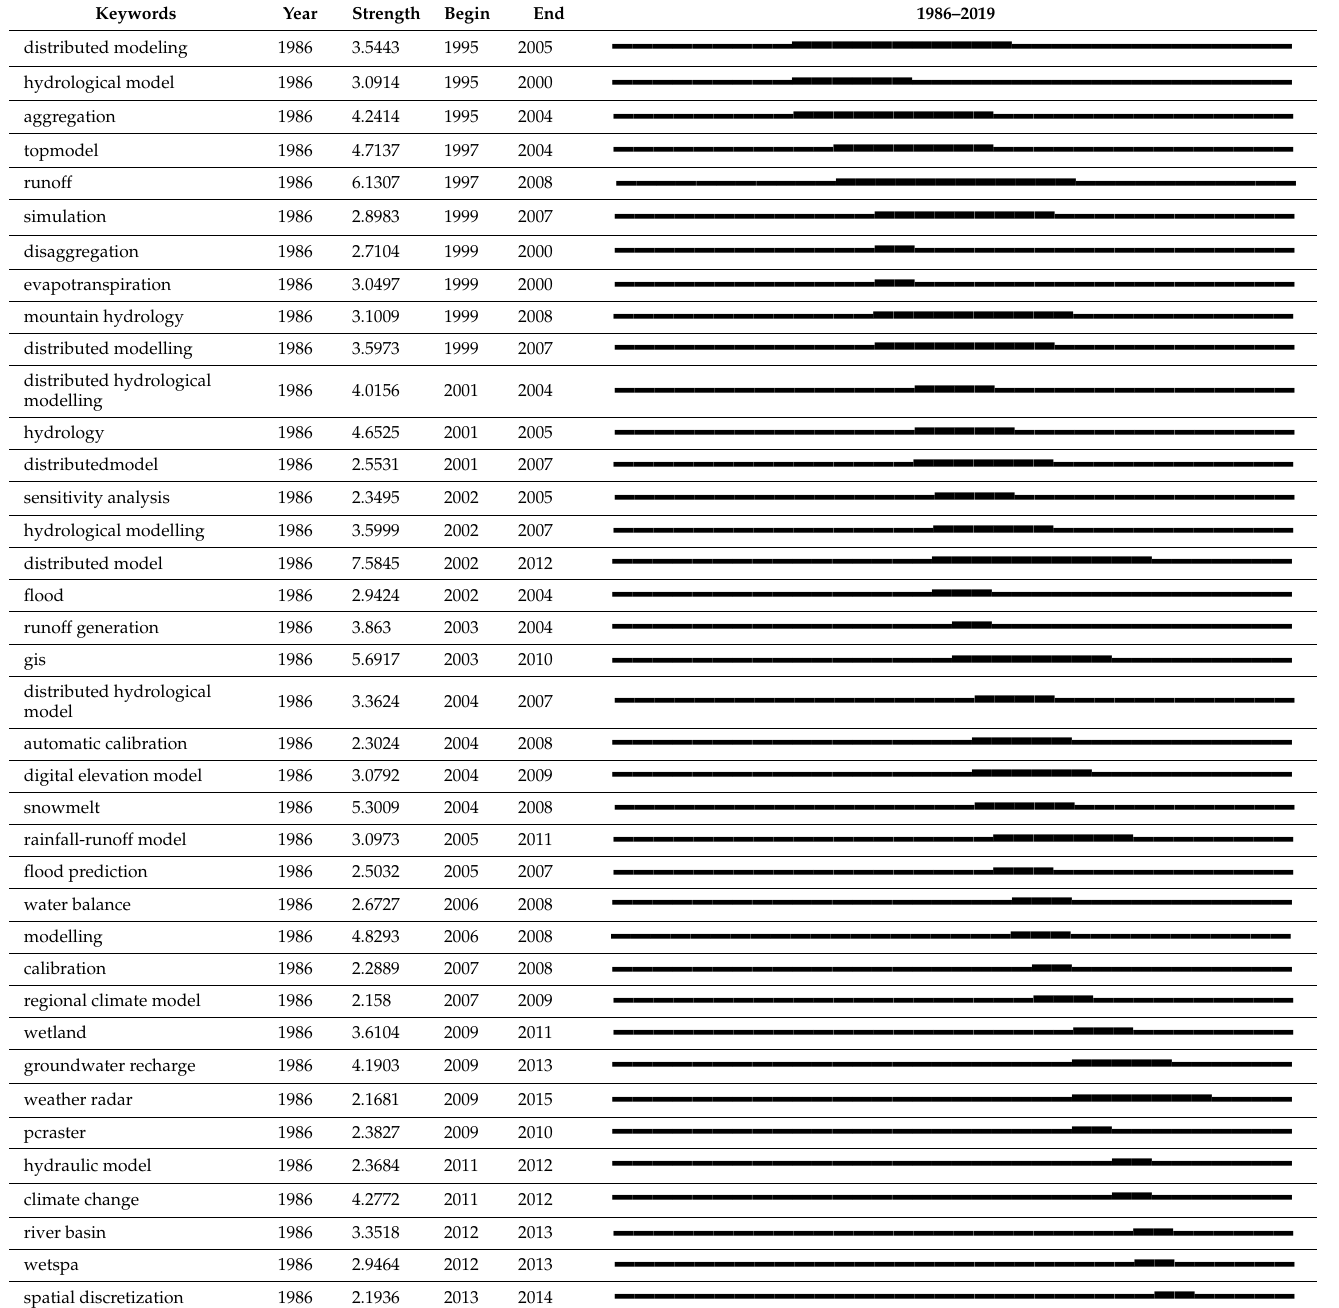
▂▂▂▂▂▂▂▂▂▂▂▂▂▂▂▂▂▂▂▂▂▂▂▂▂▂▂▂▂▂▂▃▃▃ Figure 9. Keyword co-occurrence map from January to October